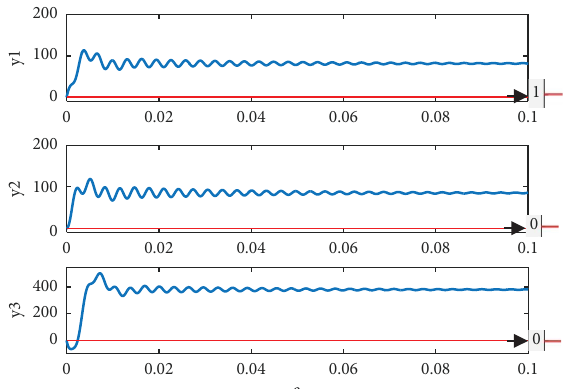
Figure 7: System response in the third mode to input [ u ] T � [1 0